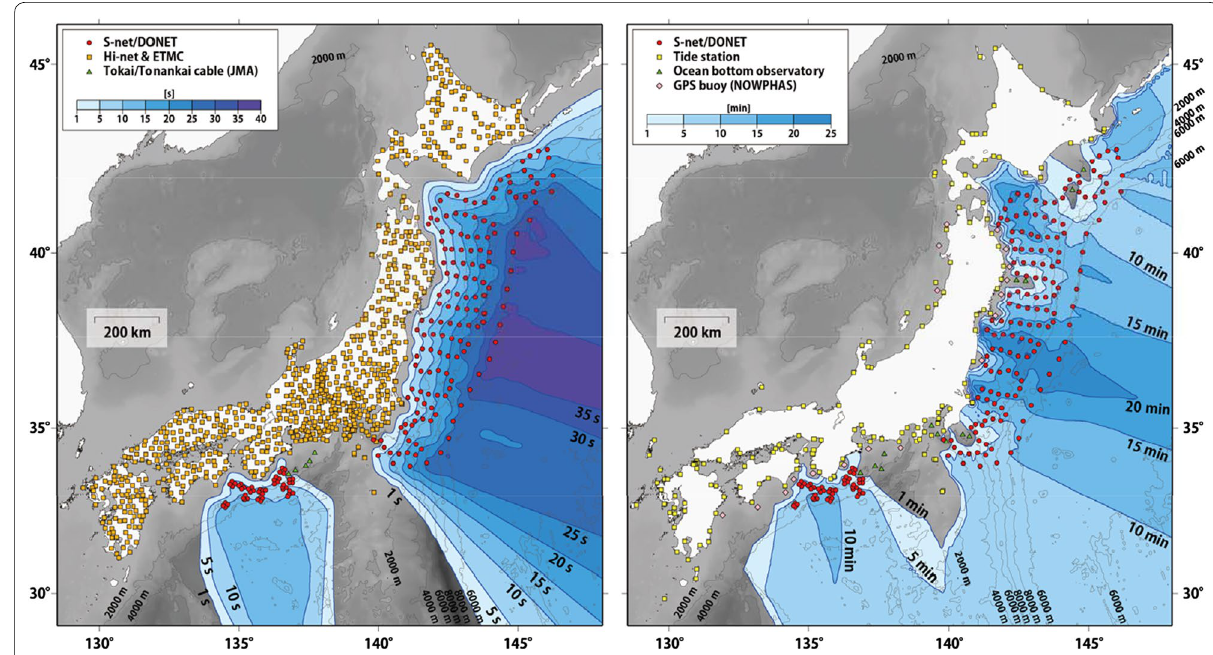
Fig. 13 Maps of simulations of the time difference of earthquake (left, in seconds) and tsunami (right, in minutes) first arrivals with and without S-net and